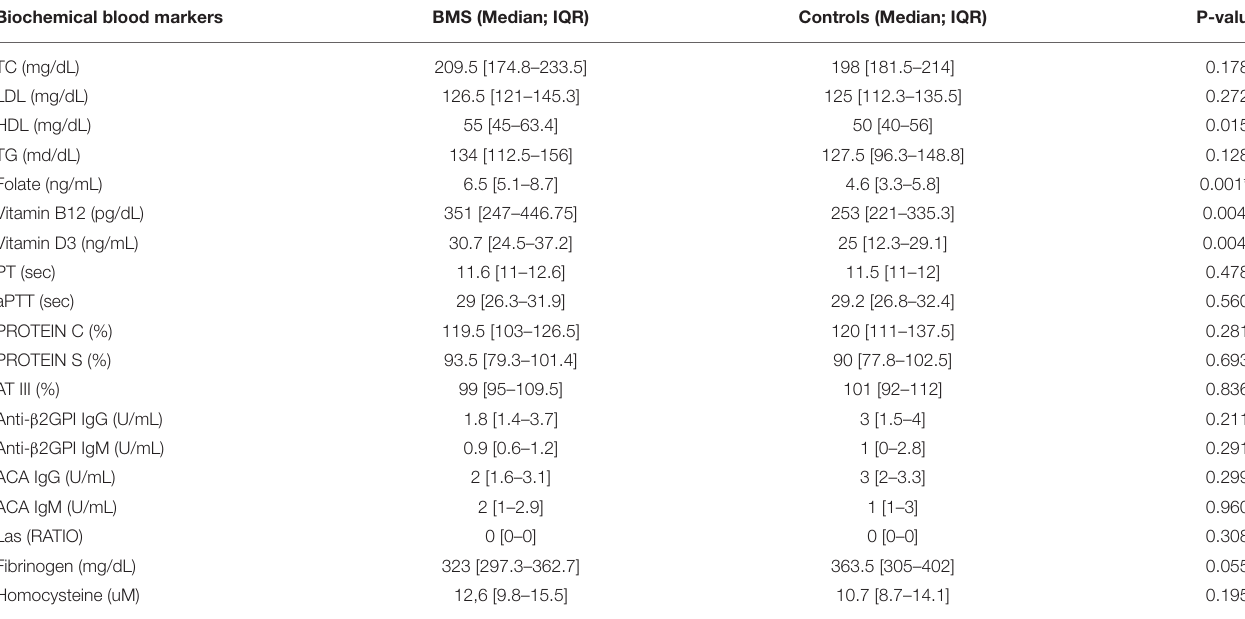
TABLE 4 | Analysis of the biochemical blood markers of patients with BMS and control subjects. Biochemical blood